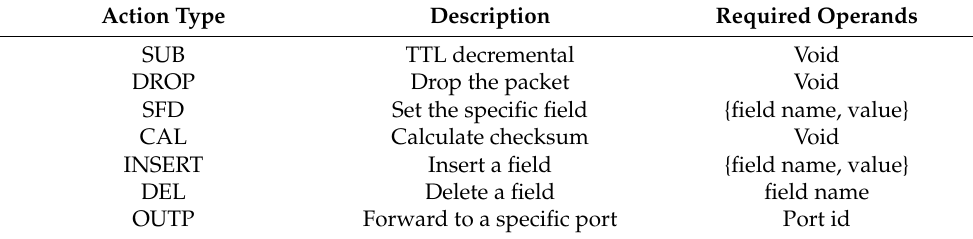
Table 1. Support action